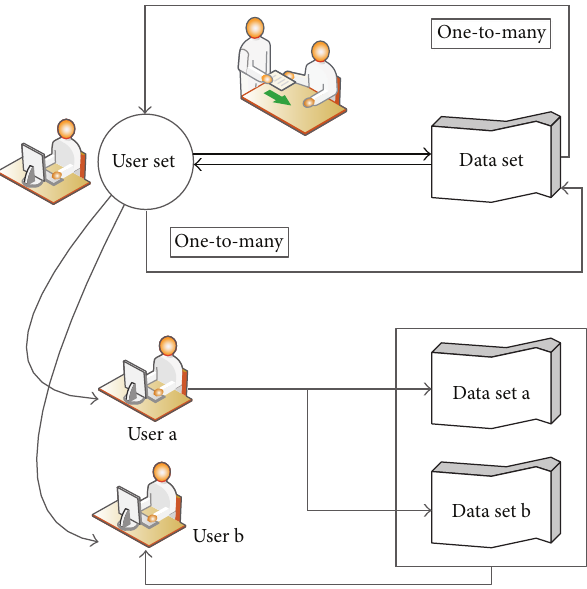
Figure 2: Mapping relationship and correlation between users and data